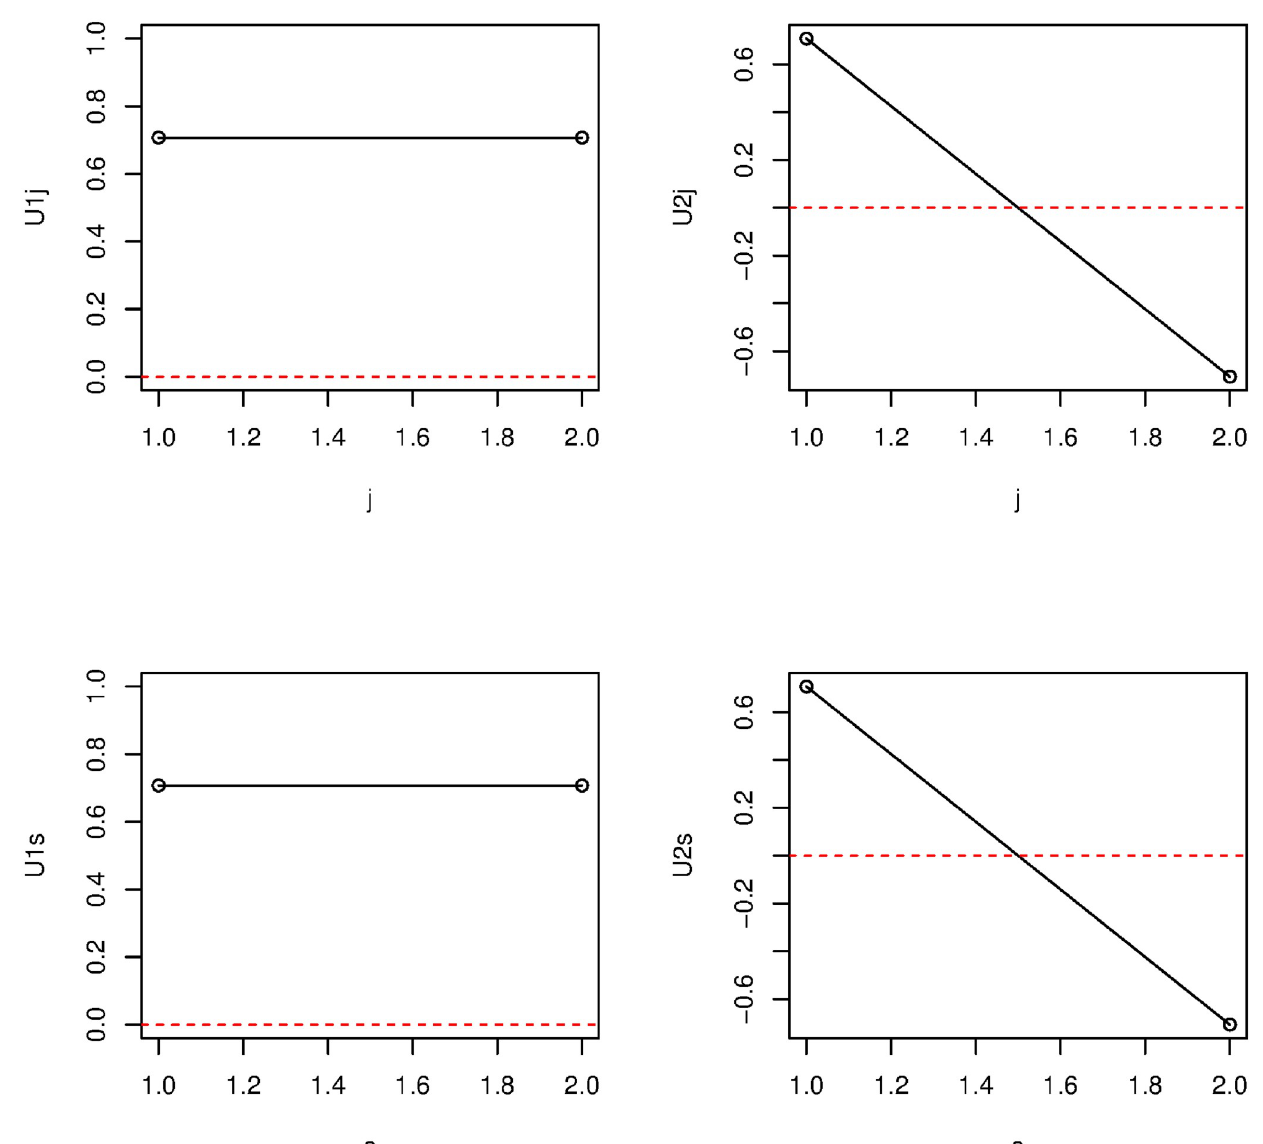
Fig 7. Dependence of vectors on cell line (j) and replicate (s). Top left: u 1 j , top right: u 2 j , bottom left: u 1 s , bottom right: u 2 s .